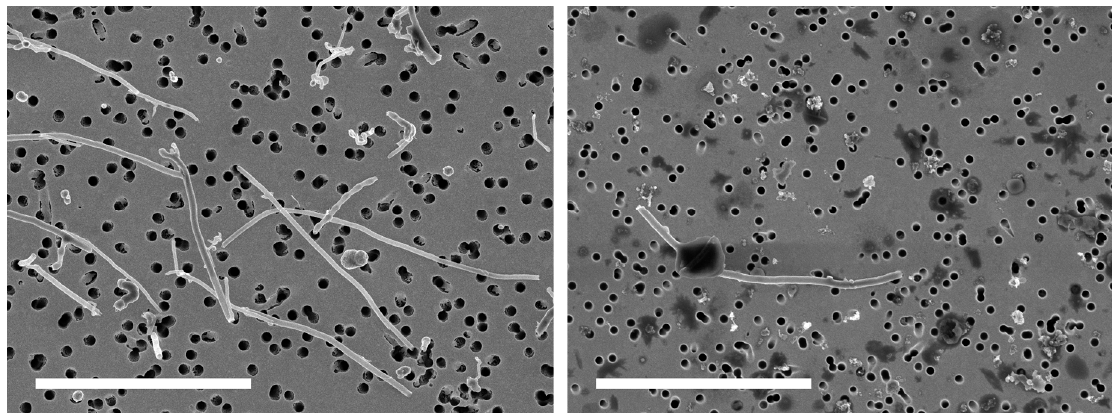
Figure 1. SEM images of the CNF material used in WP02: ( Left ) Aerosolized and sampled in the laboratory on a filter with 250 nm pore diameter. ( Right ) Filter sample of the workplace measurement with 190 nm pore diameter. The length of the scale bars is 5 μm .